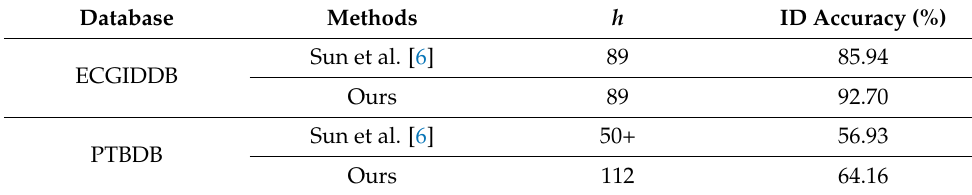
Table 14. Performance comparison of individual verification over long time